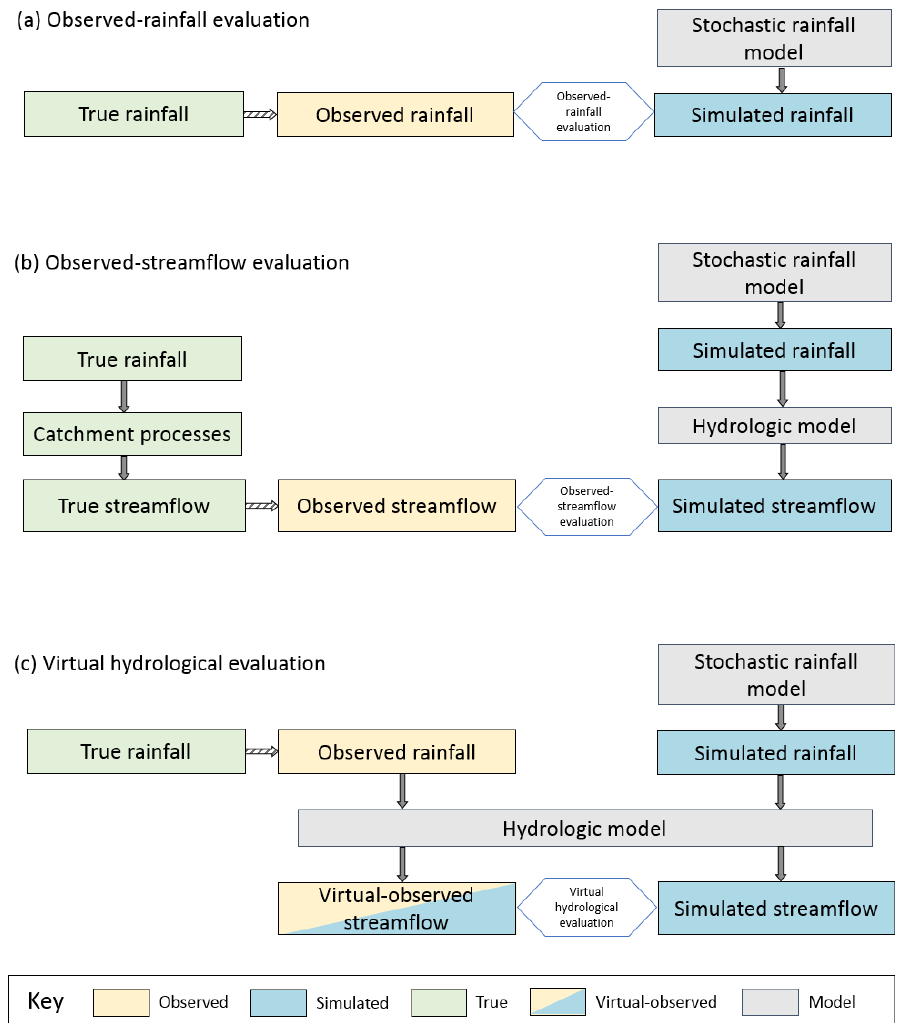
Figure 1. Schematic of (a) observed-rainfall evaluation where simulated rainfall is compared against observed rainfall and (b) observed- streamflow evaluation where simulated streamflow is compared against observed streamflow. (c) Virtual hydrological evaluation framework where simulated streamflow is compared against virtual-observed